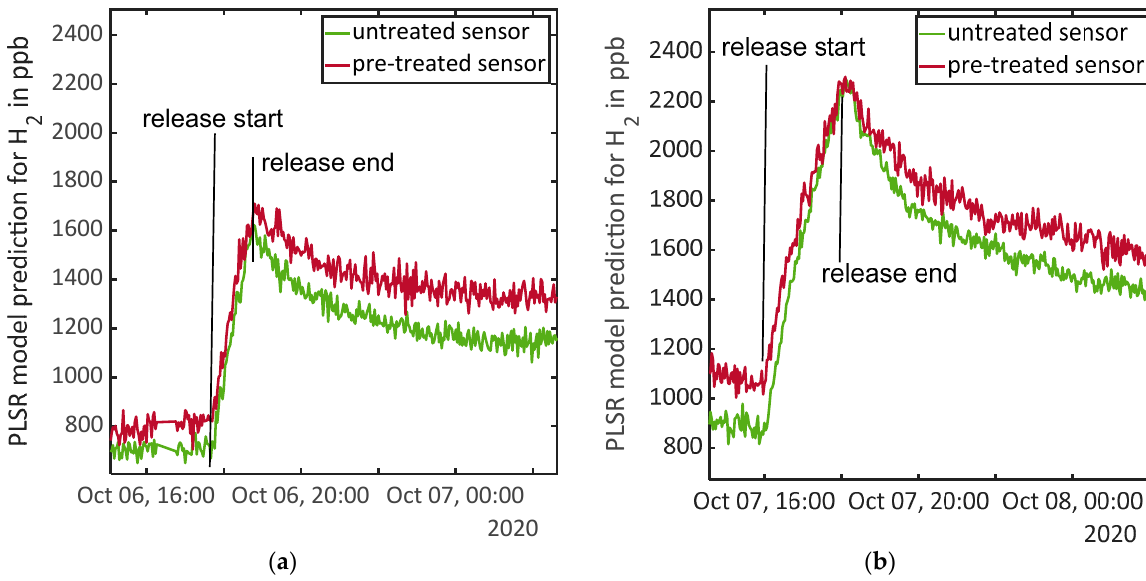
Figure 3. PLSR model predictions for H 2 for both sensors (untreated and pre-treated) during two release tests of H 2 supplied from a pressure cylinder with constant rate provided by a mass flow controller: ( a ) first release with calculated increase of 1 ppm; ( b ) second release with calculated increase of 2 ppm.